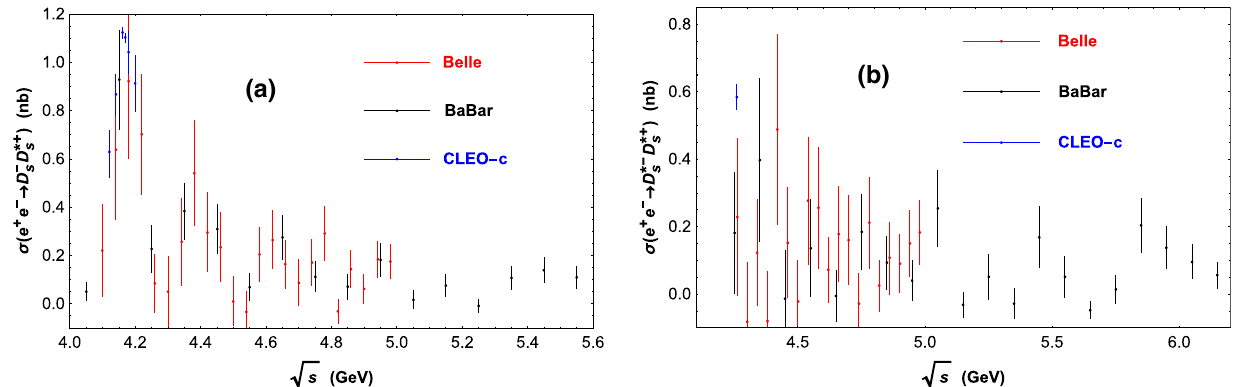
√ s (in the unit of GeV) for e + e − → D − s D ∗+ s in ( a ) and e + e − → D ∗− s D ∗+ s